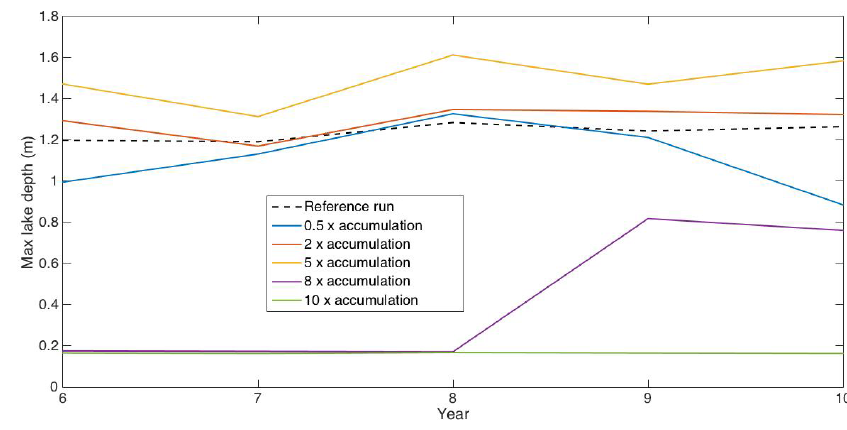
Figure 6. The maximum lake depth for years 6–10 of the simulations carried out for varying snow accumulation